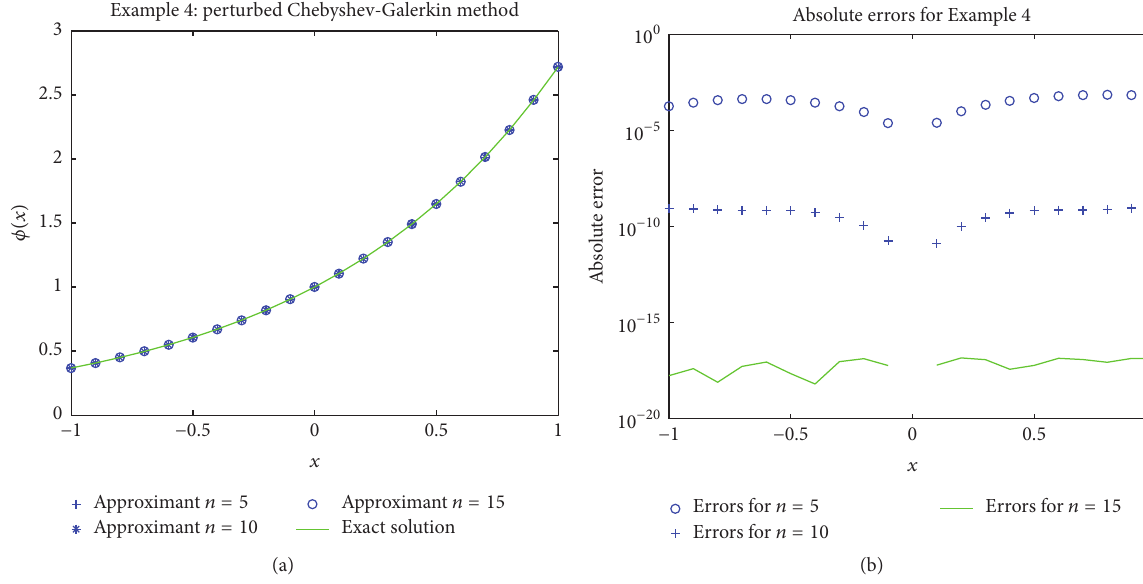
Figure 4: The approximate solution for Example 4 and its absolute errors for different 𝑛 .